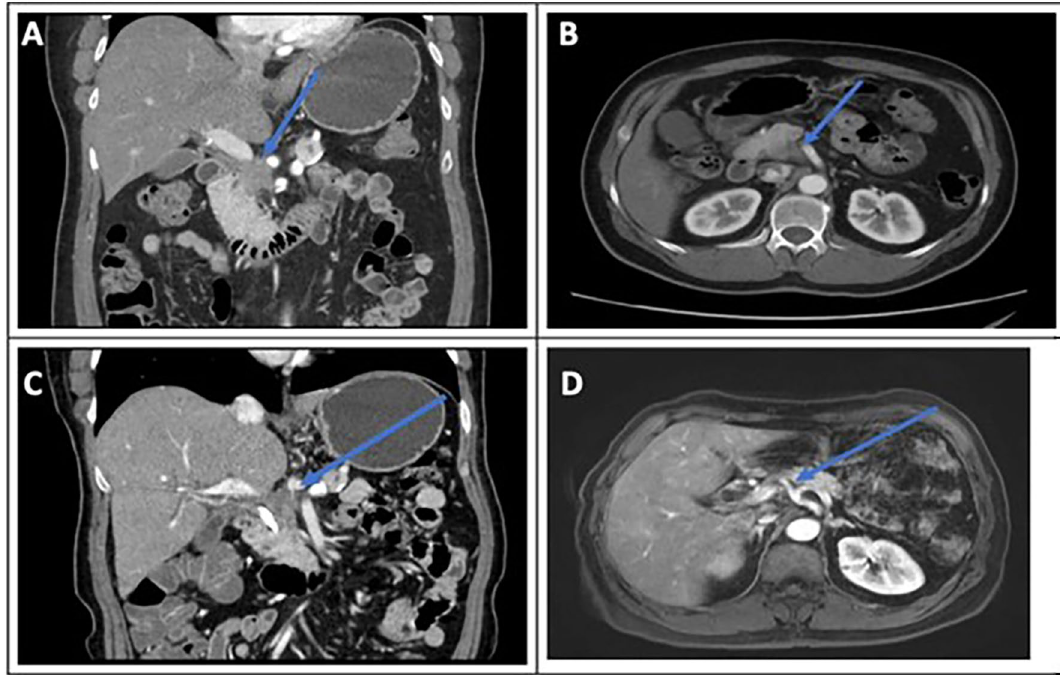
Figure 3. CT scan images from PDAC patient pre- and post-therapy who underwent margin-negative pancreaticoduodenectomy. Representative computed tomography shows reduced PDAC lesion size post RFA. ( A ) Computed tomography (CT) with pancreas head mass and evidence of portal confluence encasement. ( B ) CT with pancreas head mass and evidence of superior mesenteric artery abutment. ( C ) CT post RFA with resolution of previously seen encasement of celiac axis as evidenced by a fat plane between tumor and celiac vessels. ( D ) Magnetic resonance imaging post RFA of PDAC with no further evidence of tumoral abutment of celiac axis, superior mesenteric artery and superior mesenteric